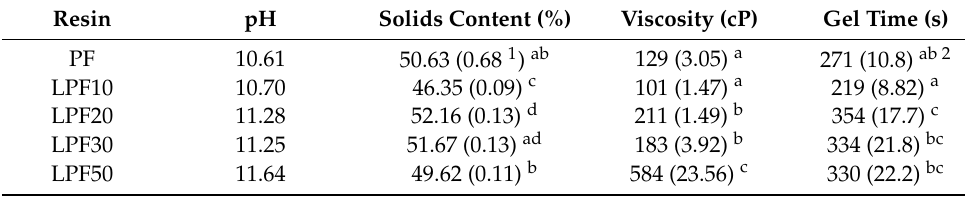
Table 2. Physicochemical properties of studied resins according to observed